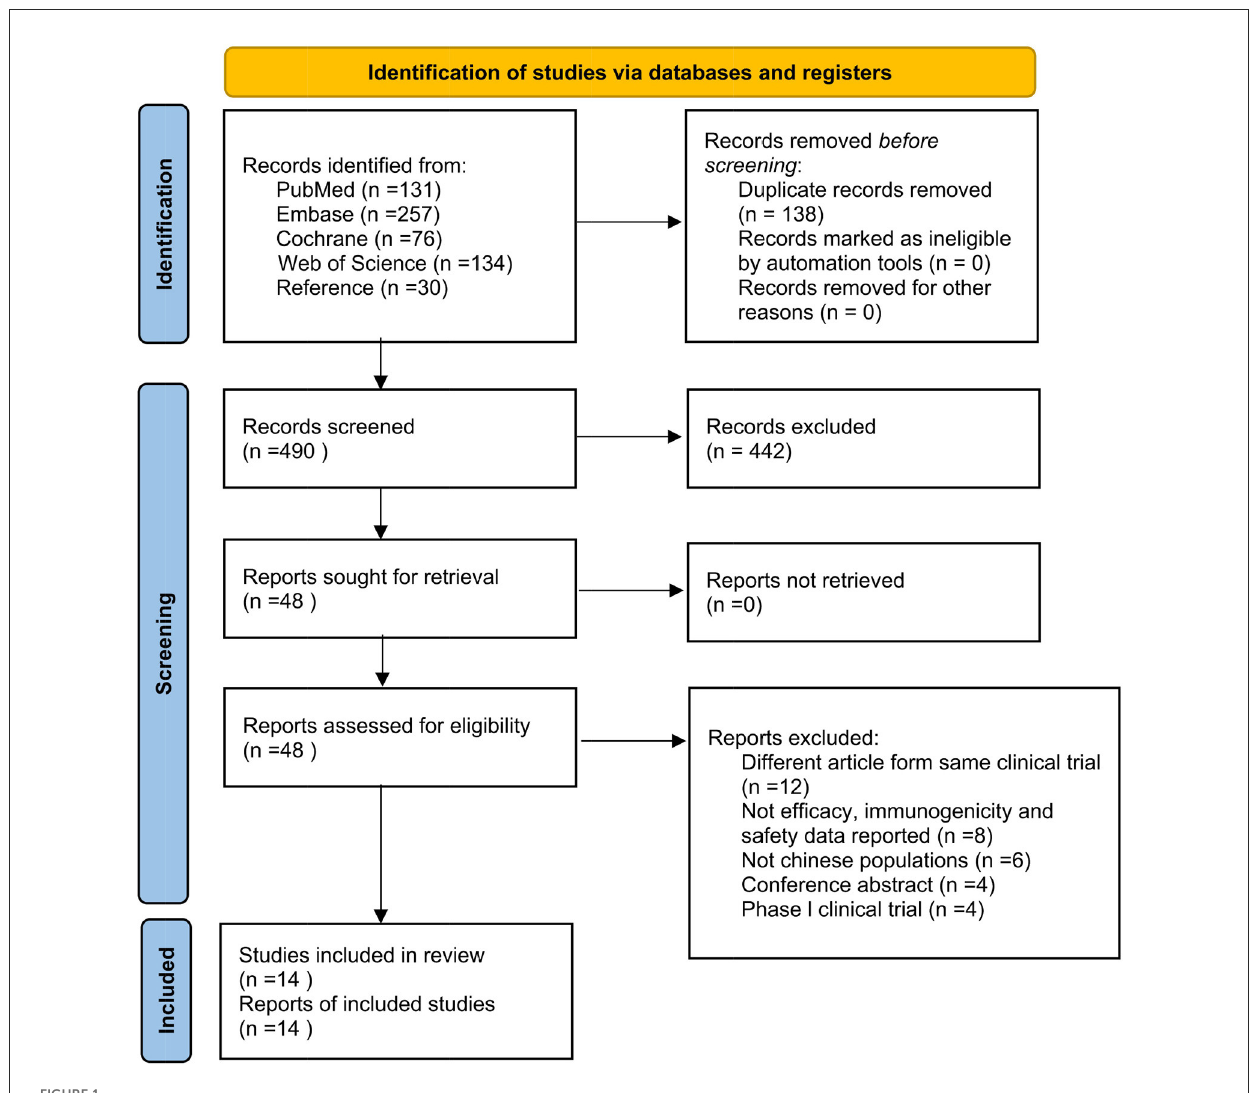
FIGURE1 Flow chart of article screening and selection